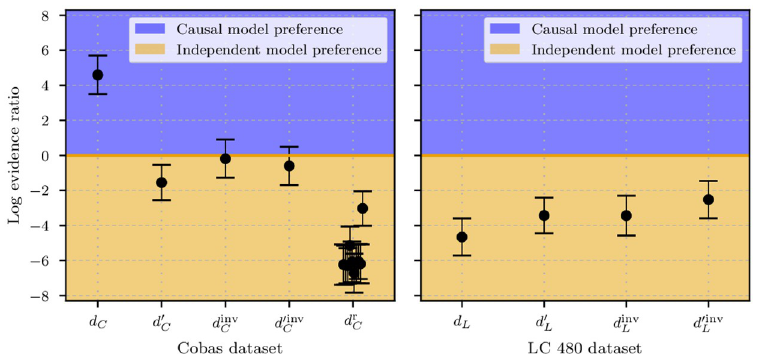
Fig 6. Evidence results. Natural logarithm of the evidence ratio with respect to the correspondent independent model for the x ! y cobas datasets d C and d 0 , for the y ! x causal model d inv and d 0 inv (left panel). The log-evidence ratios C C C labeled with d r display the ( y -)randomized datasets (for 10 different realizations). The same is also shown for the LC C 480 dataset (right). The error bars represent the numerical uncertainty associated to the stochastic estimate of the ELBO. A positive logarithm of the evidence ratio denotes a preference for the given causal model with respect to the correspondent independent model and vice versa. The strength of this preference can be determined by taking the exponential of the log-evidence ratio between the causal model and the correspondent independent one. For example, a log-evidence ratio of 5 corresponds to a e 5 � 141-fold preference for the examined causal